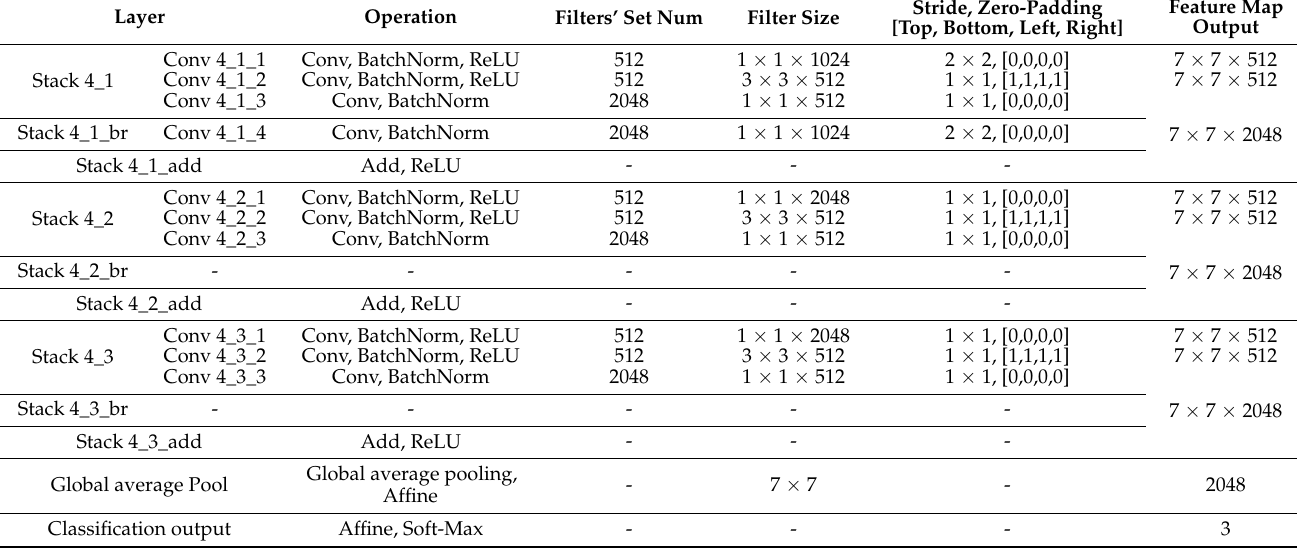
Table 4. CNN feedforward calculation from stack 4 to